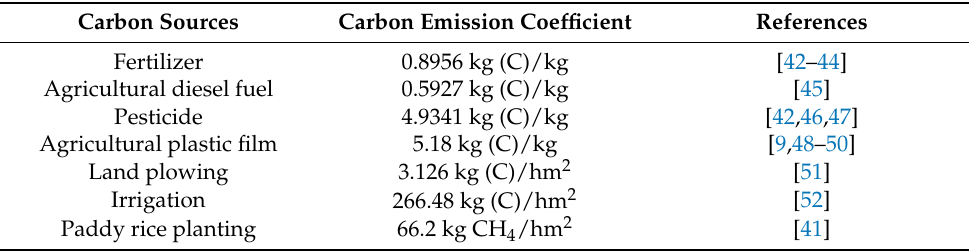
Table 1. Carbon emission coefficients of major agricultural